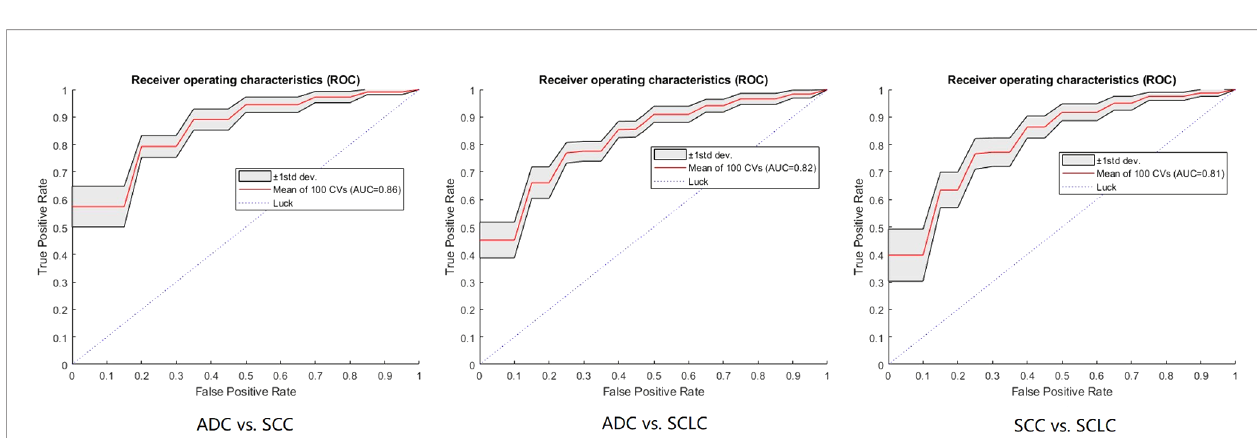
FIGURE 3 | The ROC curves of the FNN model using 100-round cross-validations. In each task curve, the red curve is the mean ROC of the 100-round cross- validations and the shadow area is the standard